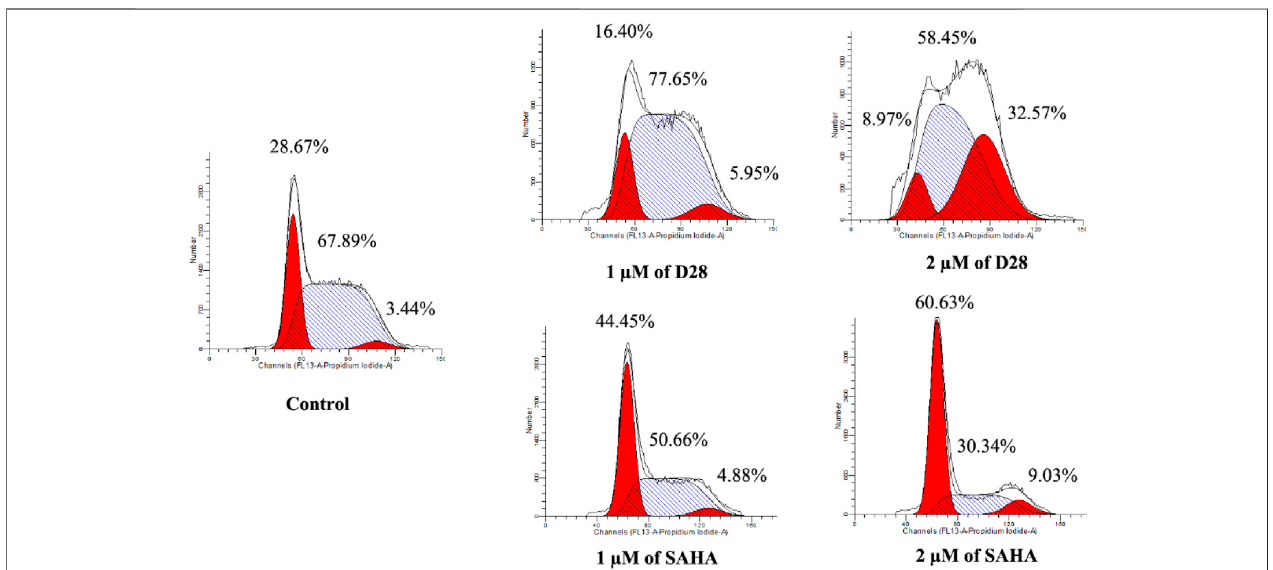
FIGURE3| Molecule D28 inducesG2/McellcyclearrestinK562cells. Cellsweretreatedwith1.0and 2.0 µMof D28 and SAHAfor24 h,and then fl owcytometry was used to detect the percentage of cells in various phases of the cell cycle.